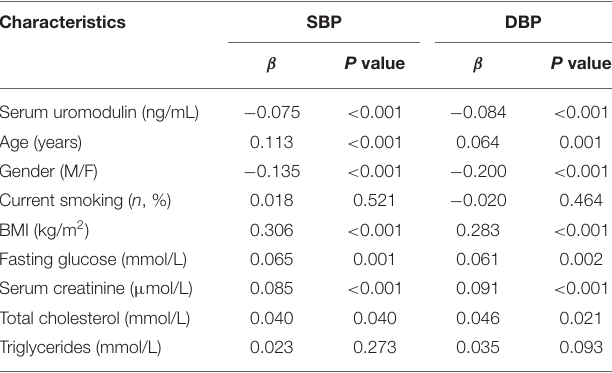
TABLE 5 | Relationships between various characteristics and BP levels ( n = 2,210).